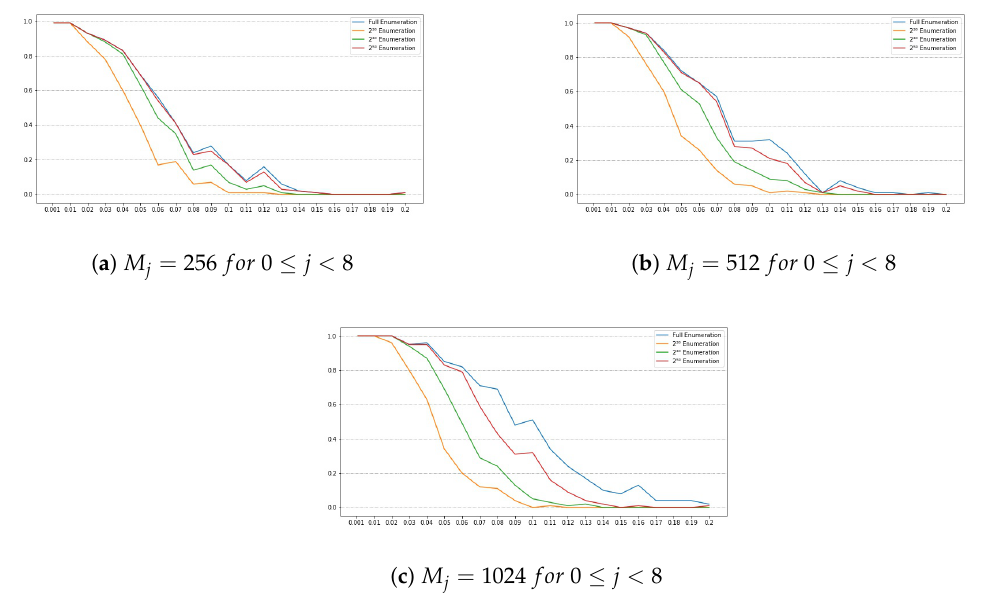
Figure 3. Success rates for the SIKE parameters SIKEp503 for α = 0.001. The y -axis denotes the success rate, while the x -axis denotes β